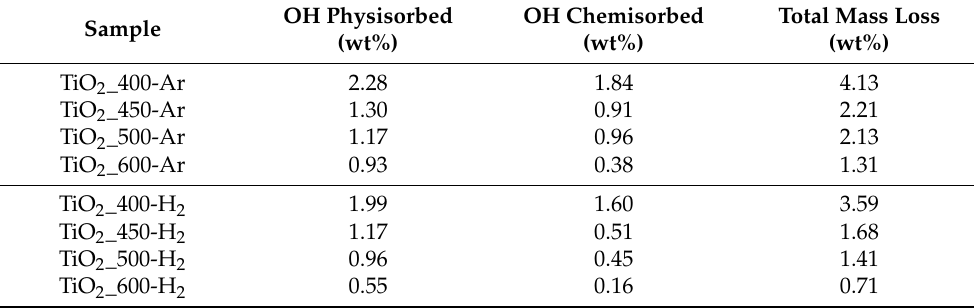
Table 2. Amount of OH groups on TiO 2 surface determined by TG analyses.